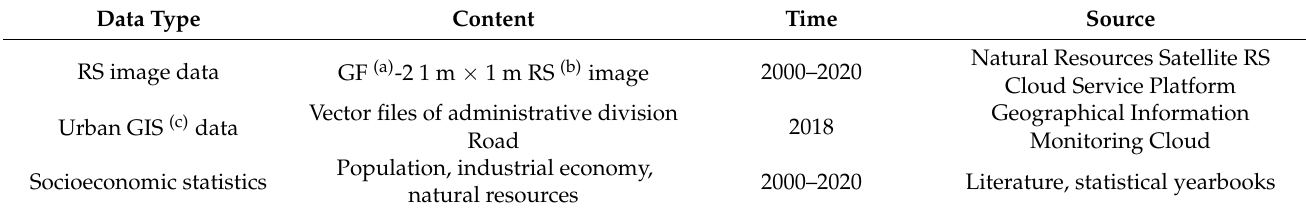
Table 2. Study data sources and